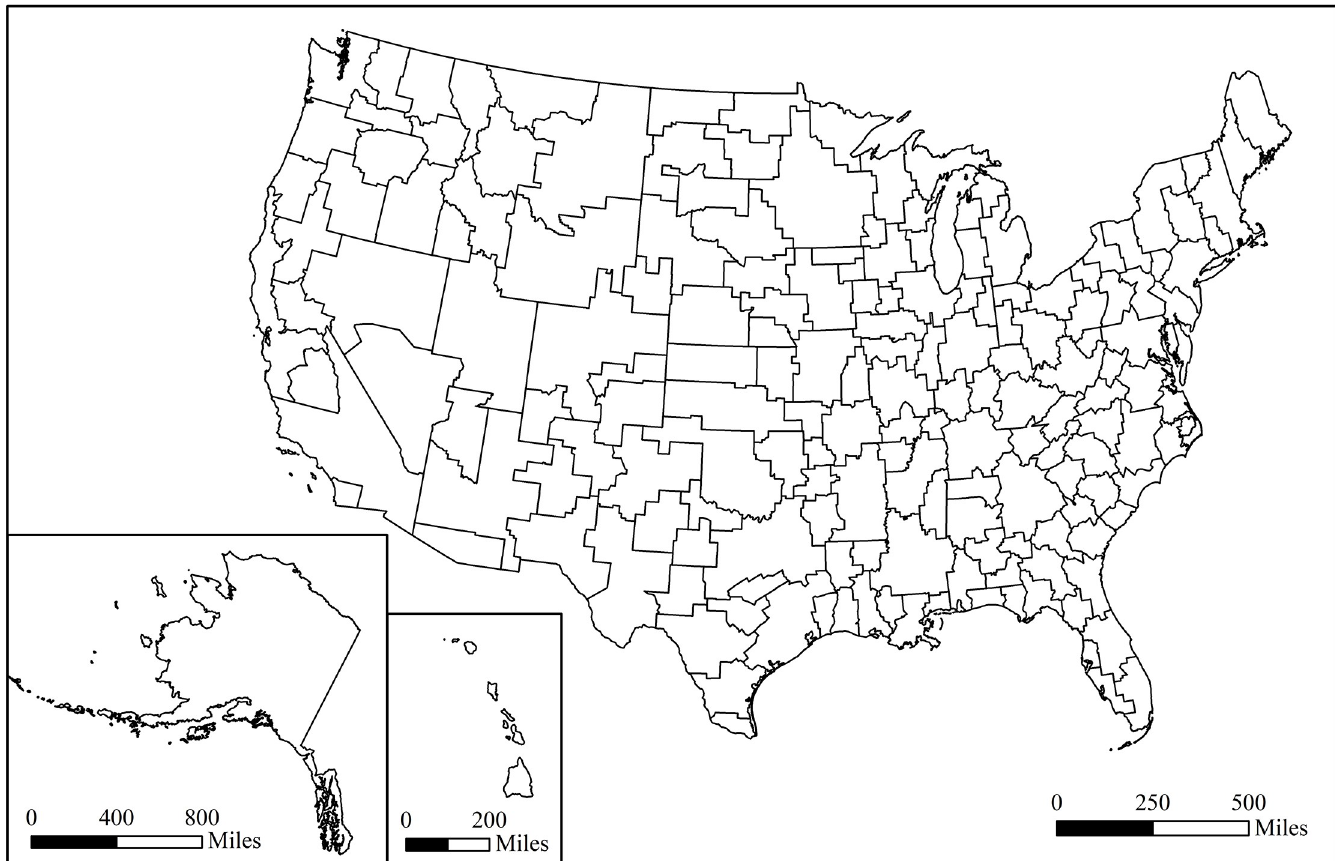
Fig 1. U.S. local labor markets, defined as BEA labor sheds.